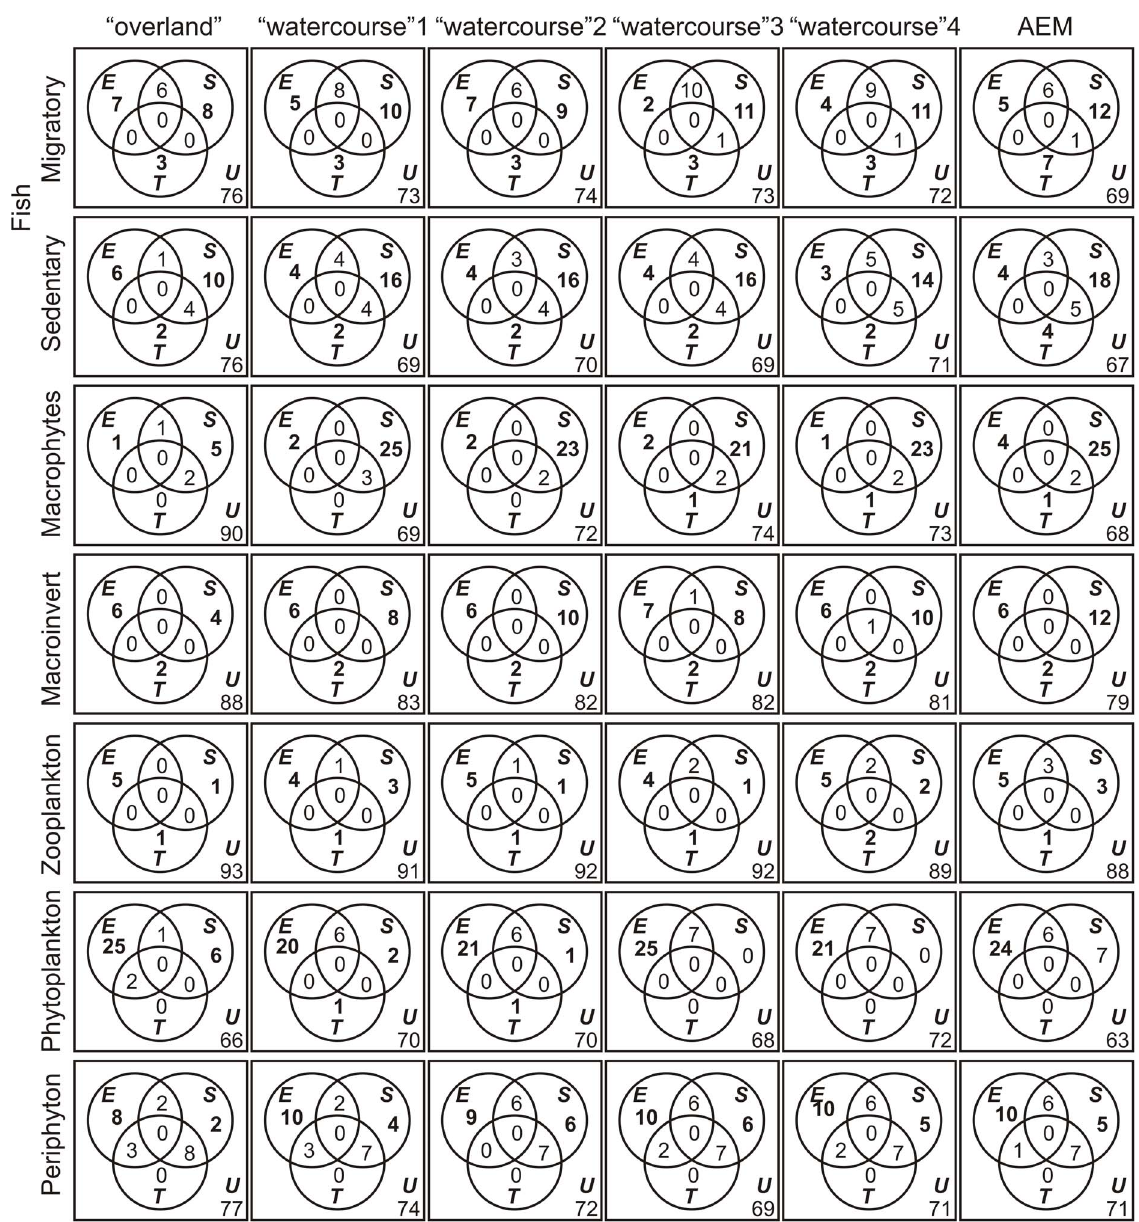
Figure 2. Results from partial redundancy analysis. Shown are the relative contributions (% of explanation) of environmental ( E ), spatial ( S ), and temporal ( T ) variables, as well as the shared components explaining variation in abundance of aquatic metacommunities (except for aquatic macrophytes, in which only presence/absence is available), using overland and four watercourse distances to generate spatial predictors. U =unexplained component. Zeros indicate values lower than 0.5%. The significance of the pure components ( E , S and T ) was tested using random permutations; bold numbers indicate significant values. Macroinvert=Benthic Macroinvertebrates.